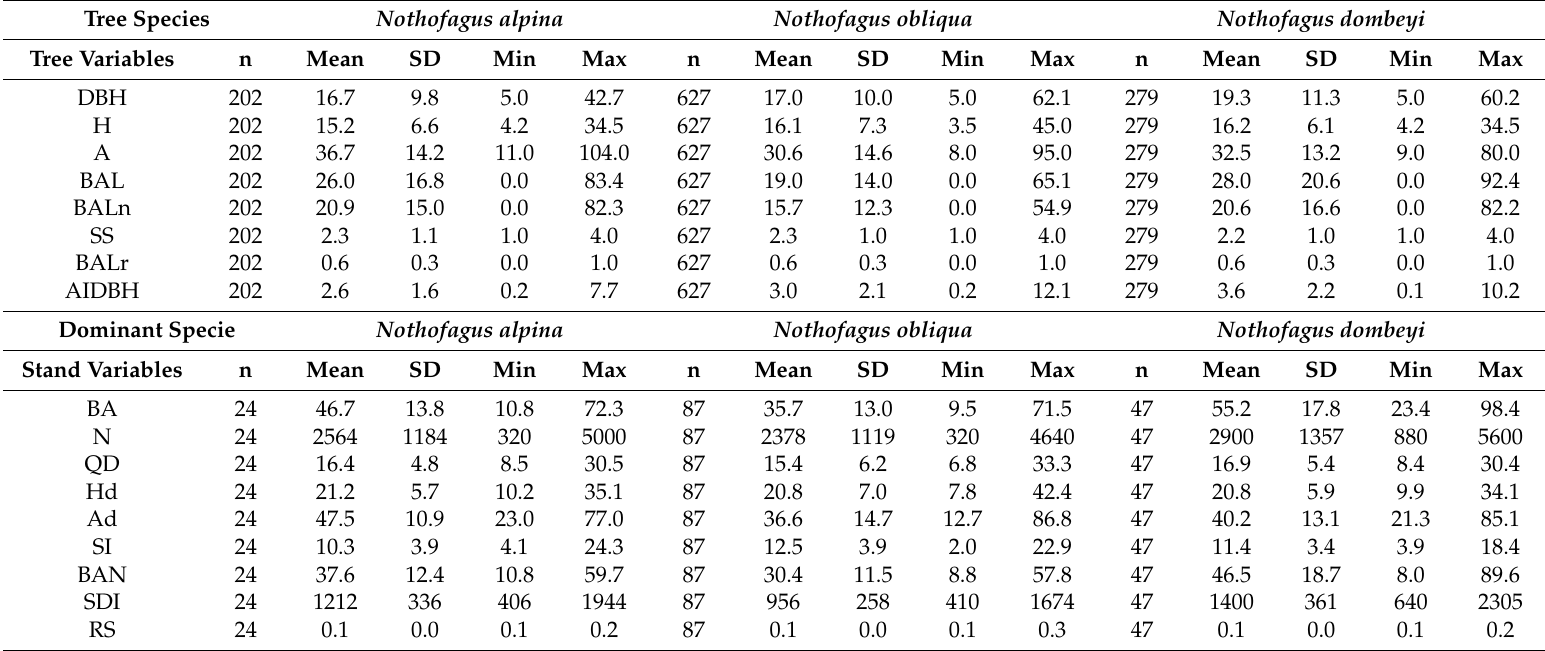
Table 1. Summary statistics of Nothofagus spp. individual and stand attributes for fitting database based on data from the permanent plots (PP) and temporary plots (TP)